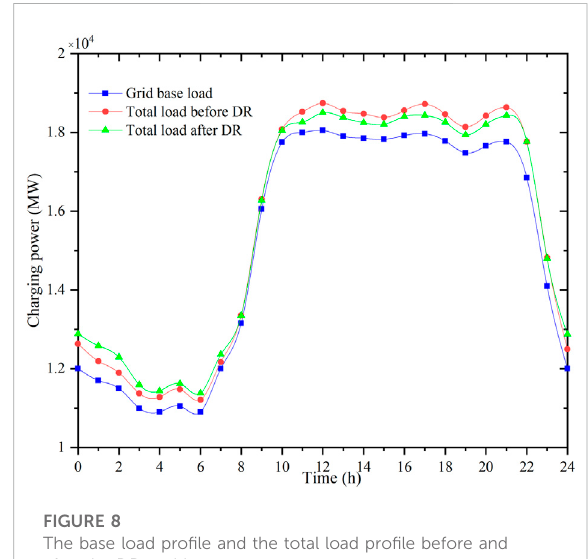
FIGURE 8 The base load pro fi le and the total load pro fi le before and after the DR